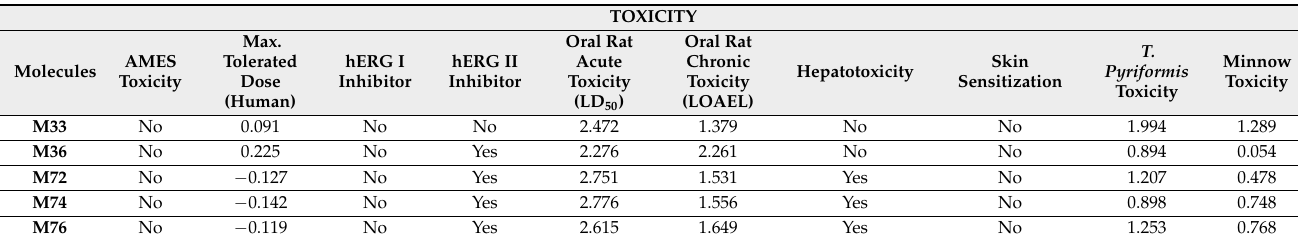
Table 7. Predicted toxicity properties of the proposed pyrazole compounds.